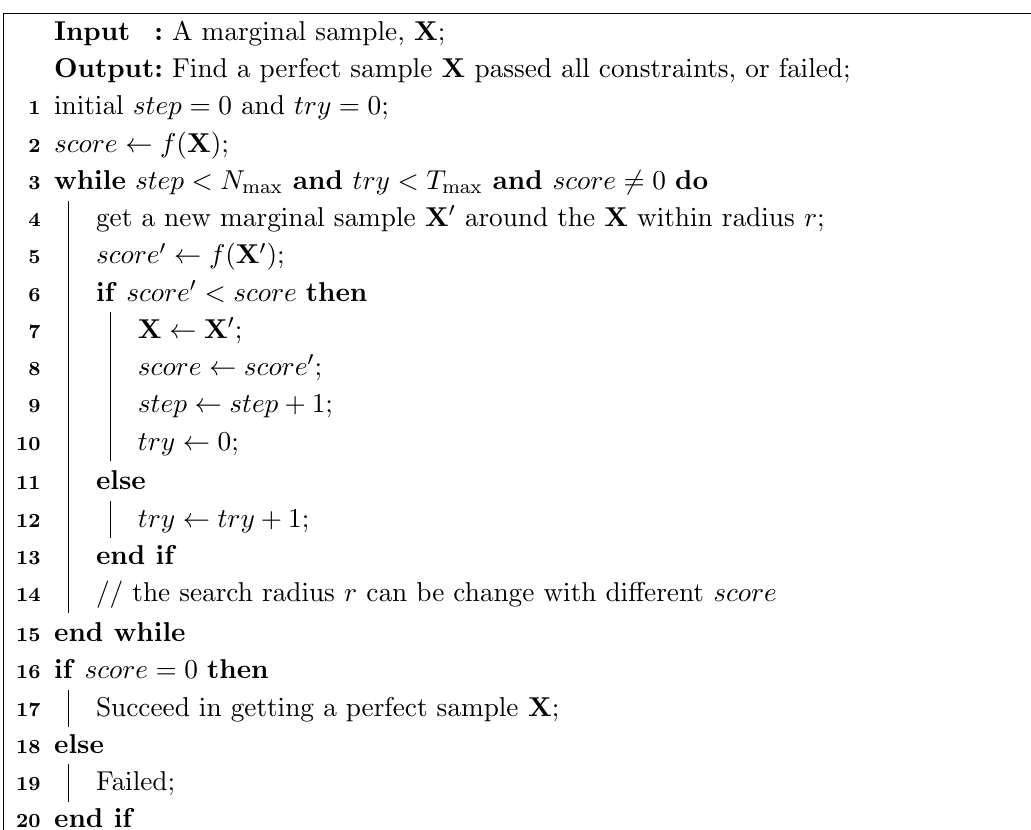
Algorithm 1 . The Heuristically Search (HS) with